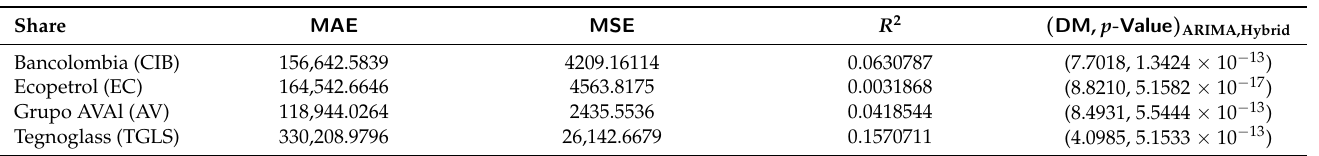
Table 3. MAE, MSE , and R 2 for the daily returns forecast using the ARIMA model. The Diebold– Mariano test was used for the prediction pair ( DM , p -value ) multiplied by 10 − 7 .